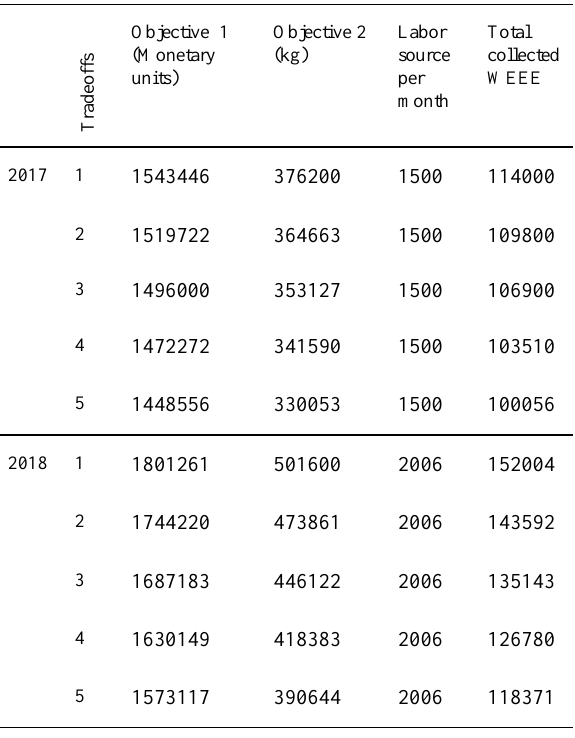
Table 4. Trade off table of 2017 and 2018 for weight based